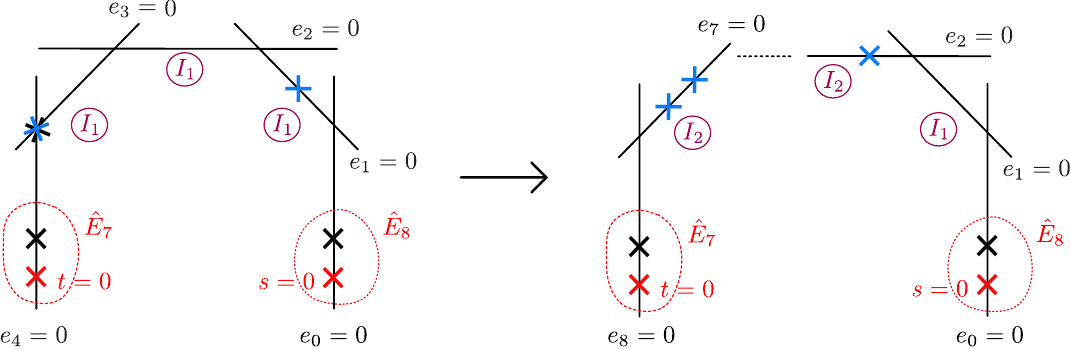
Figure 8 . Kulikov Type III degeneration of E 7 × E 8 Weierstrass model (4.34) for generic value of the parameter b and x = 0 . The left shows how for x = 0 one 7-brane from B 4 and one from B 3 1 coalesce at the intersection. The right picture shows the result of a base change and blowups. The intermediate components over B 3 up to B 6 have generic I fibers and are not explicitly 2